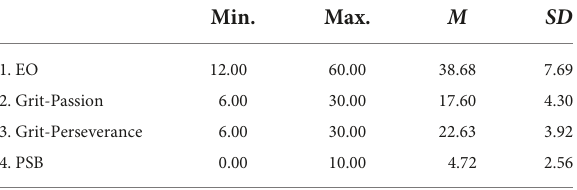
TABLE 1 Descriptive analysis of the study variables.